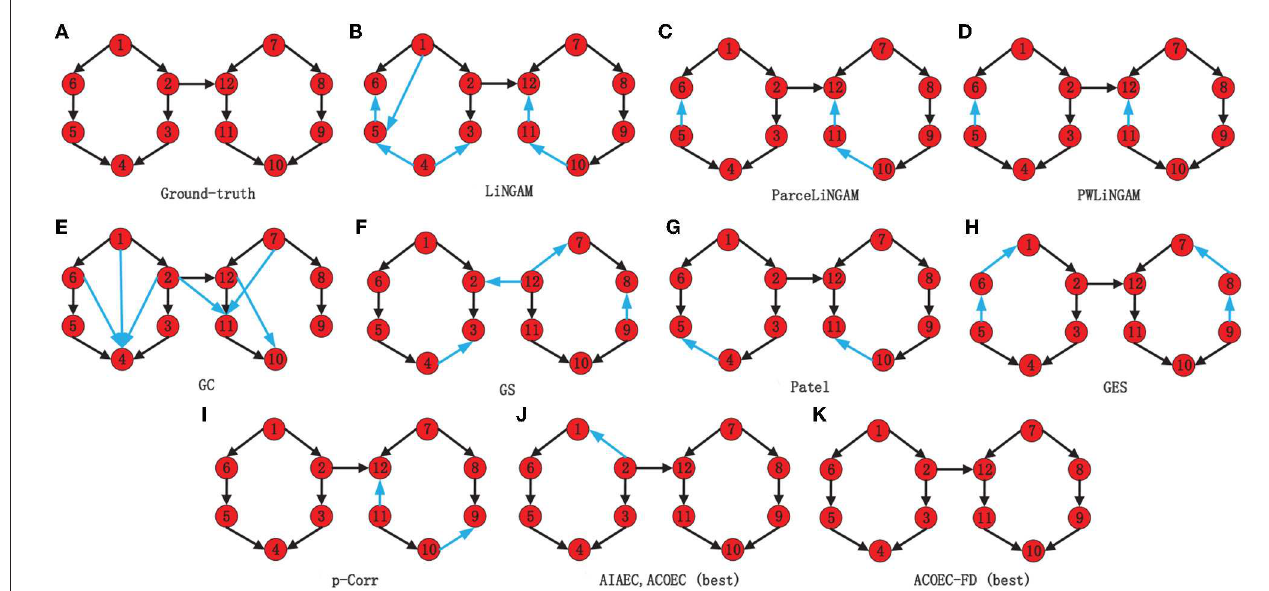
FIGURE 7 | Comparison of G net and L net by 11 different algorithms on Sim1. The eleven algorithms, which are the Ground-truth (A) , LiNGAM (B) , ParceLiNGAM (C) , PWLiNGAM (D) , GC (E) , GS (F) , Patel (G) , GES (H) , P-corr (I) , AIAEC and ACOEC (J) , and ACOEC-FD (K) , respectively. In each graph, black lines mean that the connections and directions in this graph are consistent with the G net , while the blue lines are not.